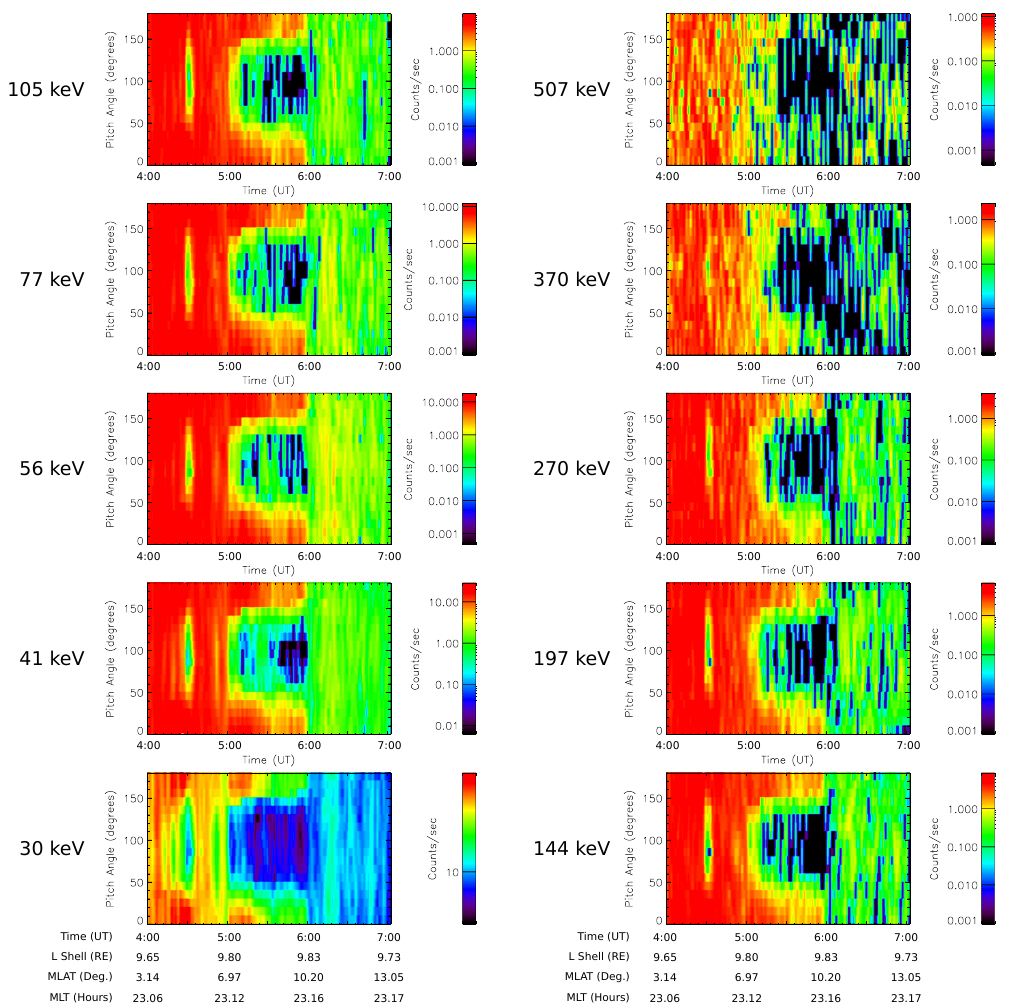
Fig. 4. Electron flux plot from the IES sensor for ten energy channels (indicated by the nominal energy threshold to the left) on Polar for 3 October 2002, with electron flux plotted as functions of pitch angle and time. Butterfly PADs occur between 05:00UT and 06:00UT with a more box-like